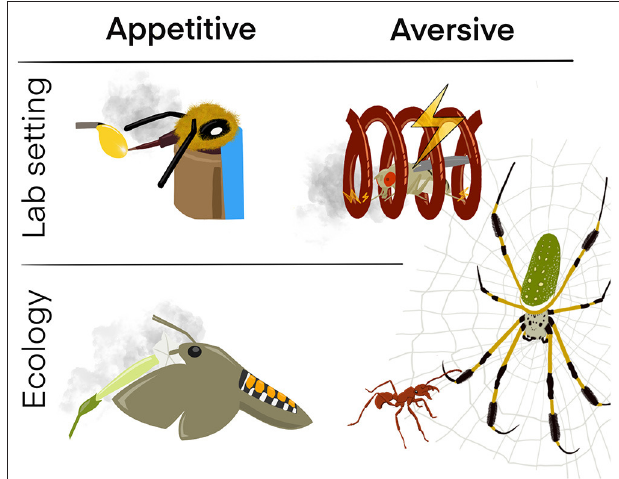
FIGURE 1 | Learning of appetitive and aversive (olfactory) cues in the lab and in the field. Appetitive-Lab setting: Honeybees ( A. mellifera ) learn to extend their proboscis when an odor (CS; gray cloud) is supplied in the presence of sugar water (US). Aversive-Lab setting: Fruit flies ( D. melanogaster ) learn to avoid an odor (CS) when perceiving the odor together with an electric shock (US). Appetitive-Ecology: Hawkmoths ( Manduca sexta ) quickly remember the smell of flowers (CS) that provide a nectar reward (US). Aversive—Ecology: The ectatomine ant Ectatomma tuberculatum learns to quickly escape the net (CS) of the golden silk spider Nephila clavipes (US) which would try to prey on the ant. Since the ant (CS) has a strong bite (US), the spider in turn learns to avoid getting near the ant if it is caught in its